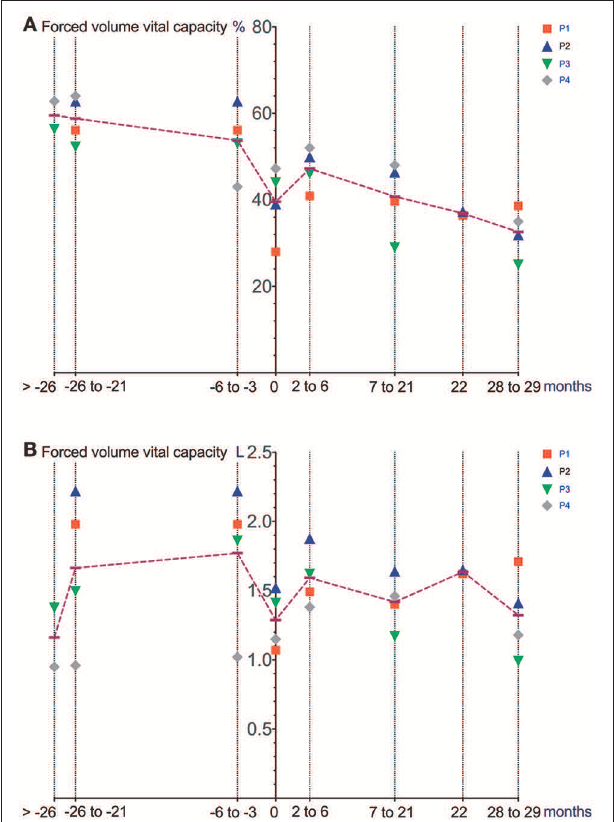
FIGURE 2 | Lung function (spirometry) prior to and after initiation of Ataluren treatment. Graphic representation of FVC [%] (A) and FVC [L] (B) in relation to time. Time point 0 represents start of Ataluren treatment in all figures (P1 and P2 13th October 2015; P3 and P4 5th February 2016). Age at start of Ataluren: P1 and P2 14 10/12 years; P3 14 9/12 years; P4 11 11/12 years). Note that time period’s alternate because of a lack of data in some values. FVC, forced volume vital